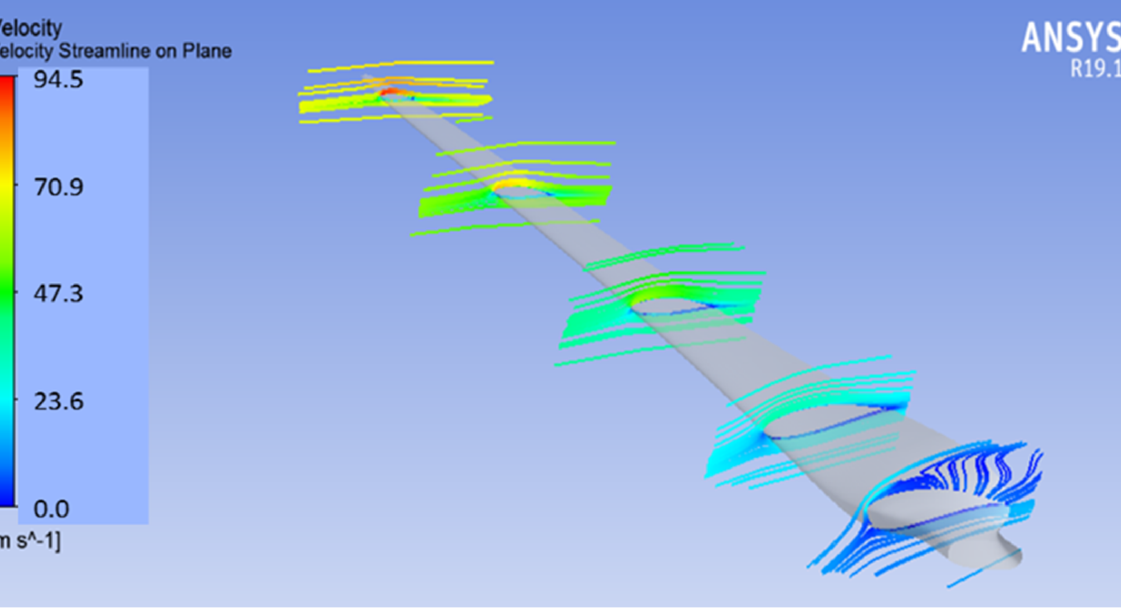
Figure 11. Velocity streamlines at design conditions of the blade surface for different radial positions.